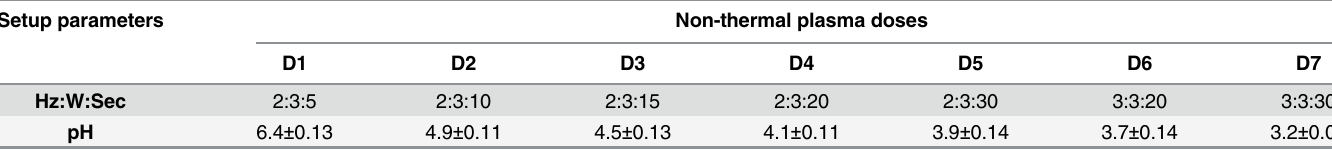
Table 1. Determination of non-thermal plasma doses as a function of pH change. Setup parameters